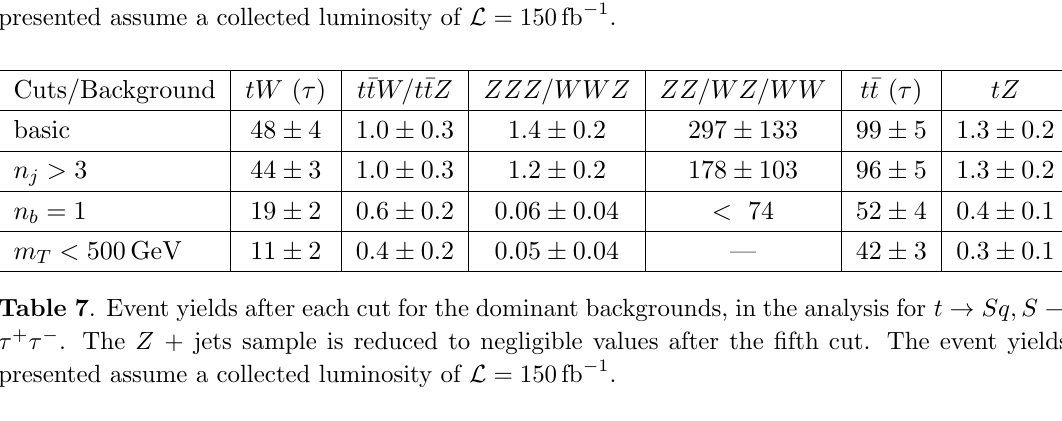
Table 6 . Event yields after each cut for the seven benchmark signal points, in the analysis for t ! Sc; S ! (cid:28) + (cid:28) (cid:0) . We (cid:12)x Y 23 = Y 32 = 0 : 1, (cid:3) = 1 TeV and B ( S ! (cid:28) + (cid:28) (cid:0) ) = 1. The event yields presented assume a collected luminosity of L = 150 fb (cid:0) 1 .